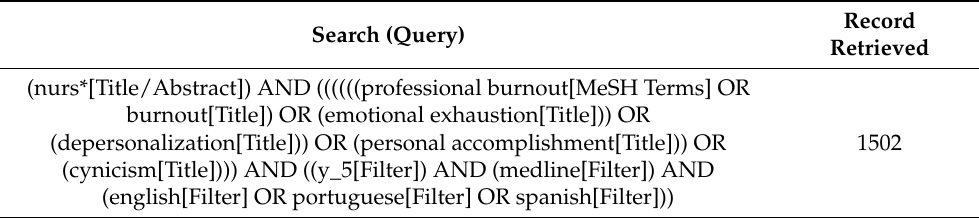
Table 1. Search conducted in Medline (PubMed). Search (Query)